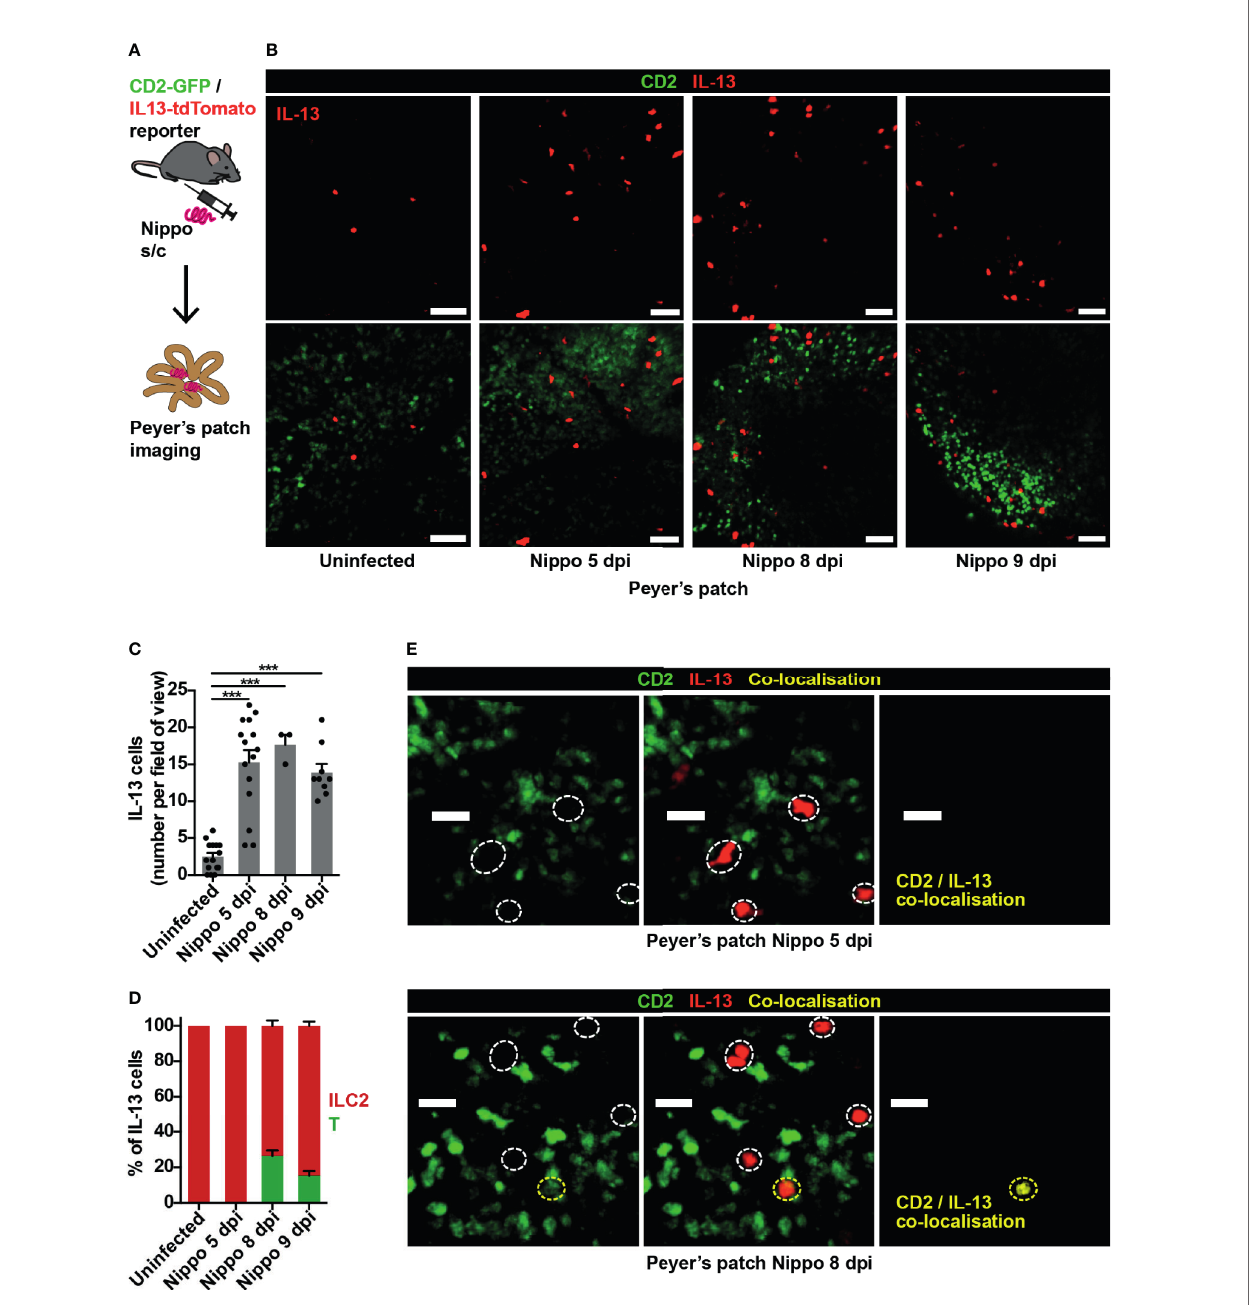
FIGURE 1 | ILC2s are present in PP at baseline and expand following helminth infection. (A) Schematic of experimental setup. (B) Intravital images of IL-13 + ILC2s in PP in mice uninfected and 5, 8, 9 days post infection (dpi) with N. brasiliensis (Nippo); scale bar 50 µm, Z 40 µm. (C, D) Quanti fi cation of (C) ILC2 numbers and (D) proportions of IL-13 + T cells (CD2 + ) vs ILC2s (CD2 neg ) per fi eld of view; *** p < 0.001 vs uninfected. Pooled data from 1-5 movies from 1-3 mice per time-point, each dot representing one fi eld of view, total of 444 cells in 42 fi elds of view examined. (E) Intravital images of PP 5 and 8 dpi showing co-localisation of CD2 and IL- 13; scale bar 20 µm, Z 50